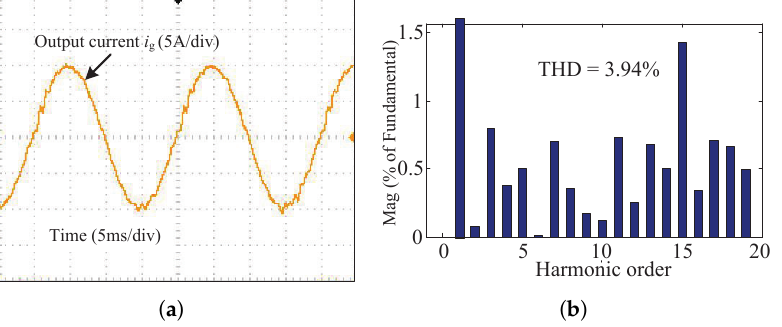
Figure 11. PIMR-type RC ( m = 4) control system with k r = 6: ( a ) The output current waveform; ( b ) The output current spectrum analysis.